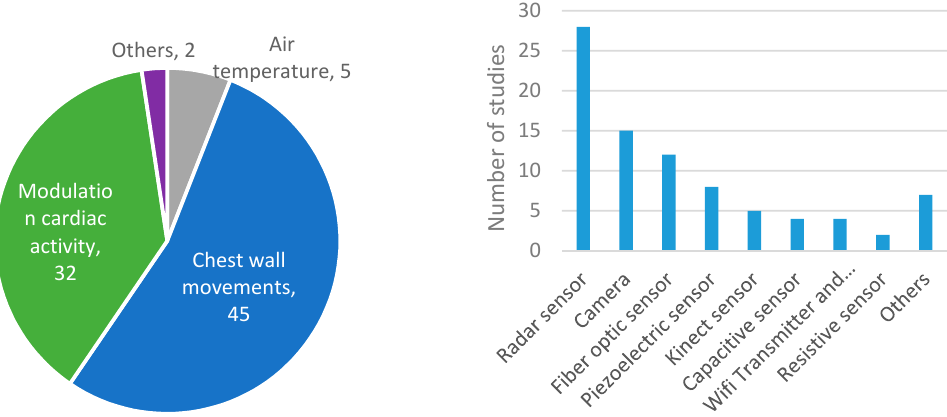
Figure 7. Distribution of sensing techniques ( left ) and sensors ( right ) used in the studies of the environmental category.